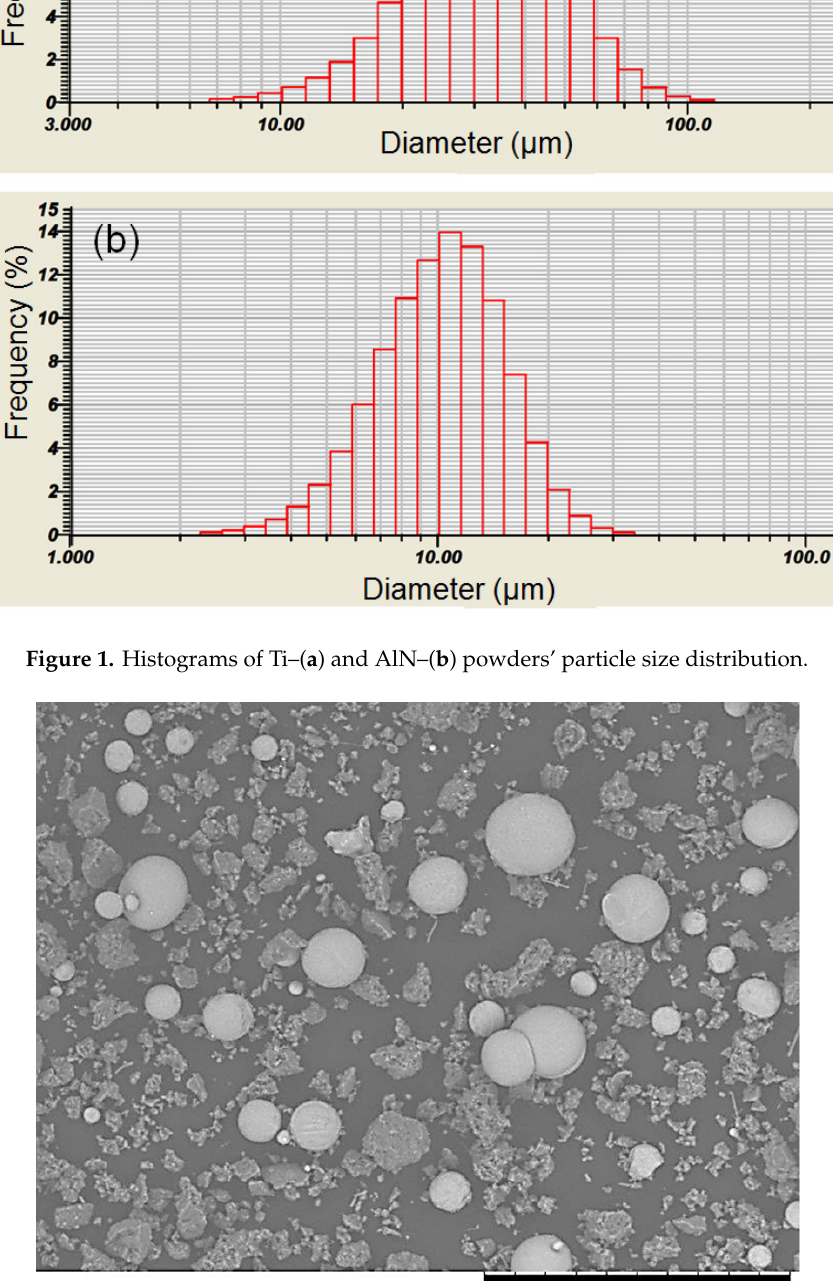
Figure 2. Scanning Electron Microscope (SEM) image of the Ti and AlN powder mixture.